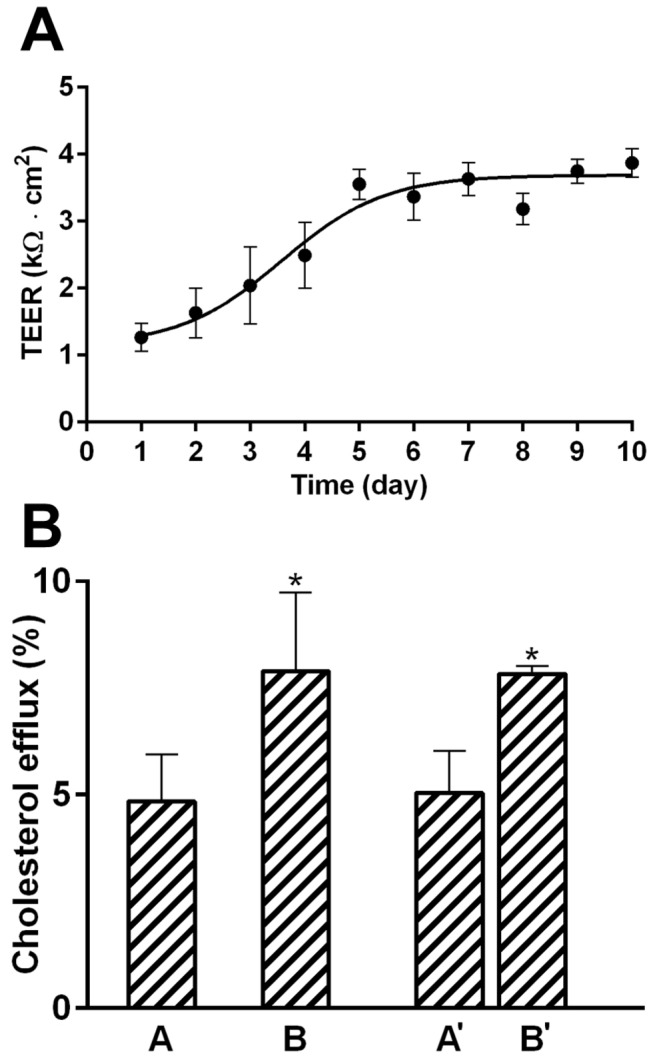
Vectorial 3H-cholesterol transport in primary bovine mammary epithelial (MeBo) cells. A: Time-dependence of the trans-epithelial electrical resistance of MeBo cells grown as monolayer in Transwell® tissue culture plates. MeBo cells were exposed to DMEM-F12 medium supplemented with 10% fetal calf serum and 1% antibiotics/antimycotics that was added to the apical and basal chambers.Resistance was measured according to the manufacturer’s instructions in quadruplicates of >12 wells. Trans-epithelial electrical resistance was calculated according to [41]. B: Vectorial apoA-I mediated 3H-cholesterol efflux in MeBo cells. The experiment was performed according to the optimized protocol (loading 1h, equilibration 1h, efflux 1h). All other details of the procedure were as described in Figure 4B. ApoA-I was added either to the apical (A) or to the basal (B), or to both chambers (A’, B’). ApoA-I mediated cholesterol efflux was calculated separately for the apical and the basal chamber by subtracting the background efflux. All data are expressed as means ± SD of triplicates measurements.